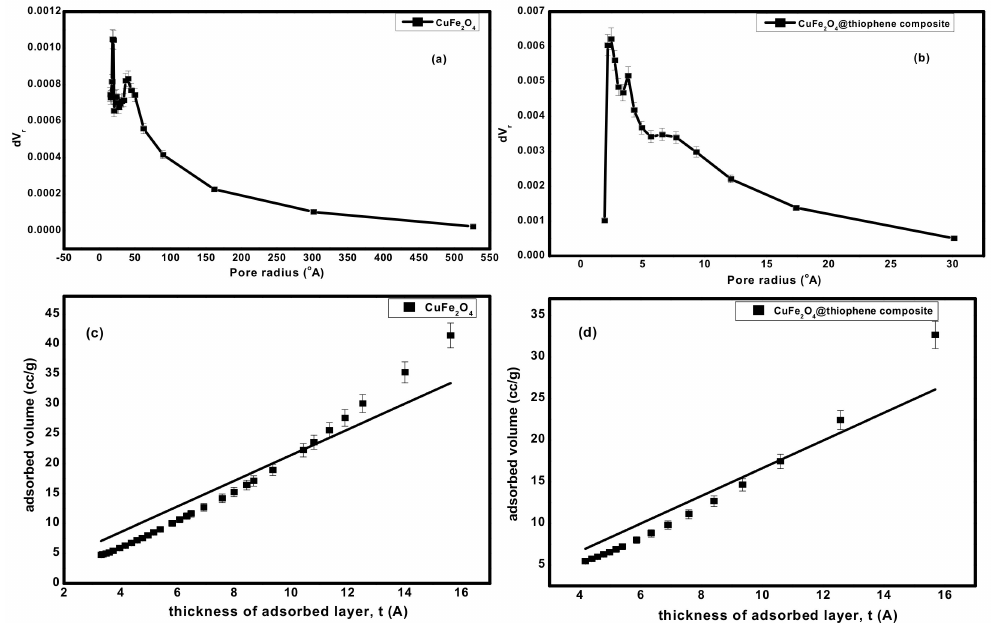
Figure 5. ( a , b ) pore size distribution of CuFe 2 O 4 and CuFe 2 O 4 @Polythiophene composite; respectively and ( c , d ) t-plot of CuFe 2 O 4 and CuFe 2 O 4 @Polythiophene composite; respectively.